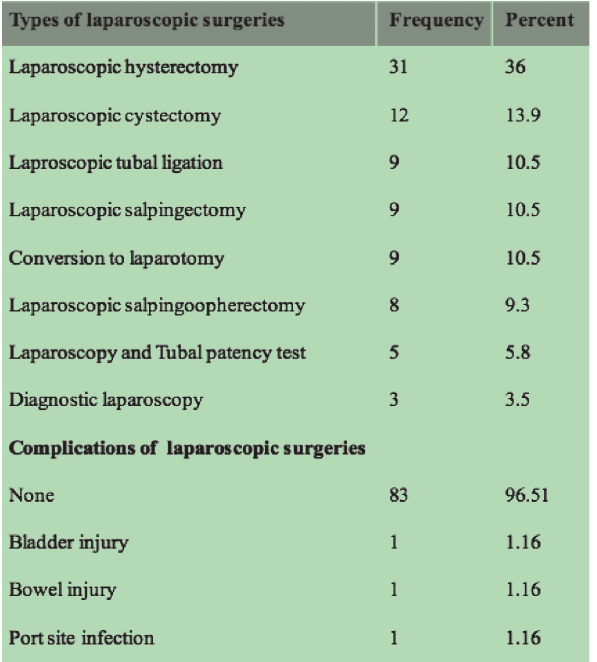
Table 3: Types and complications of laparoscopic